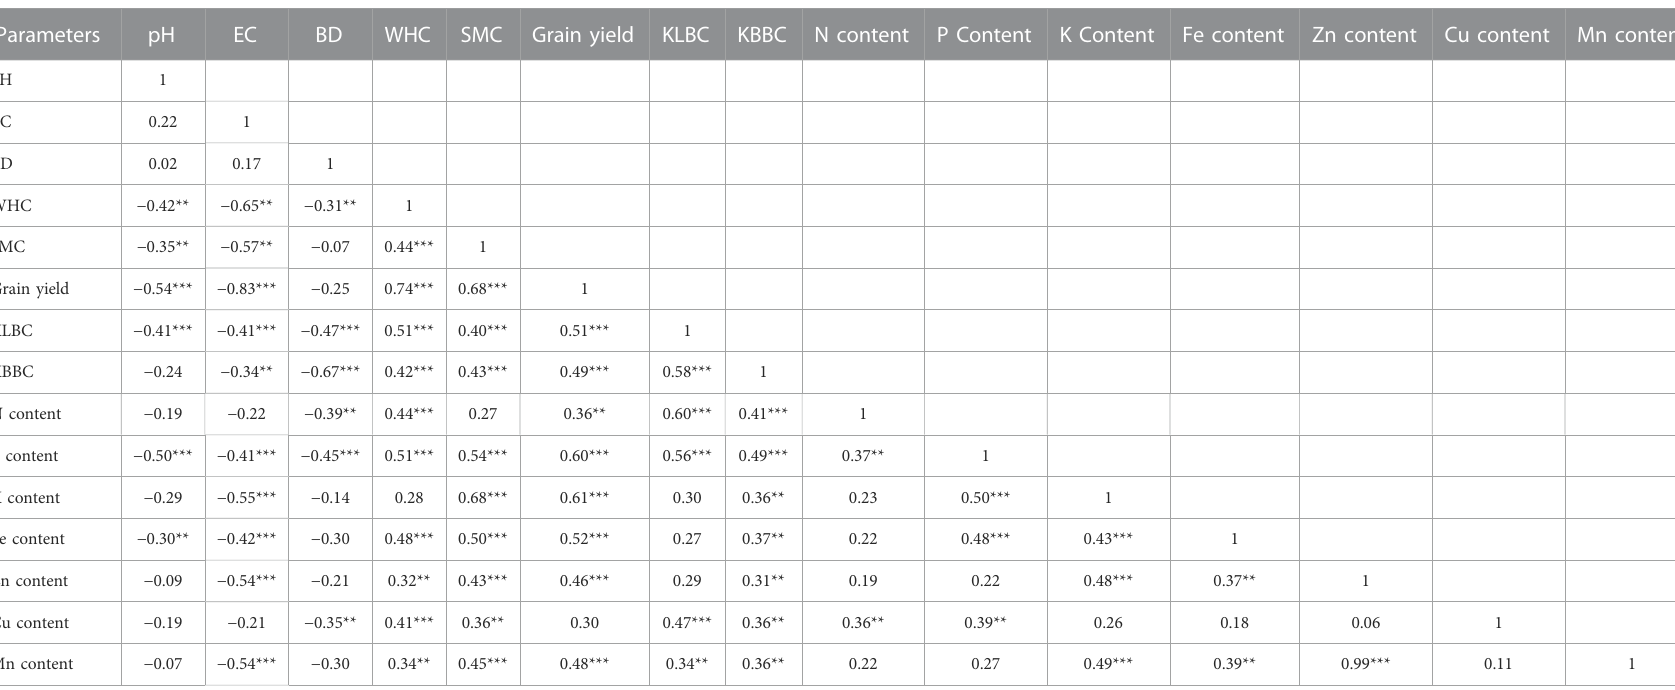
TABLE 5Correlation matrix of different soil (pH,EC, BD,WHC, andSMC) and grainquality (KLBC, KBBC, N,P, K,Fe,Zn,Cu, andMn contents) parameters under different cropping systems and nutrient management